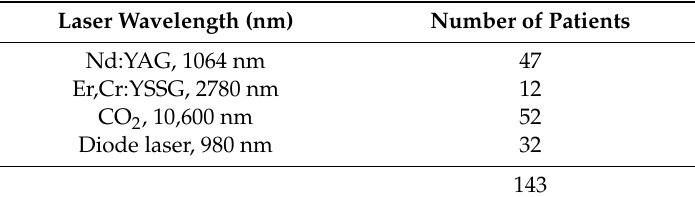
Table 2. Repartition of the type of laser used for each patient.